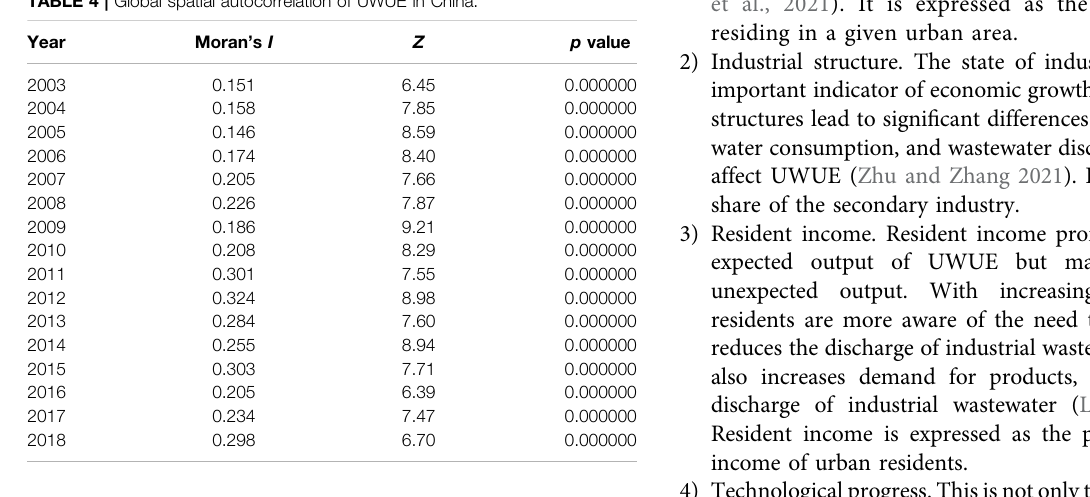
TABLE 4 | Global spatial autocorrelation of UWUE in China.